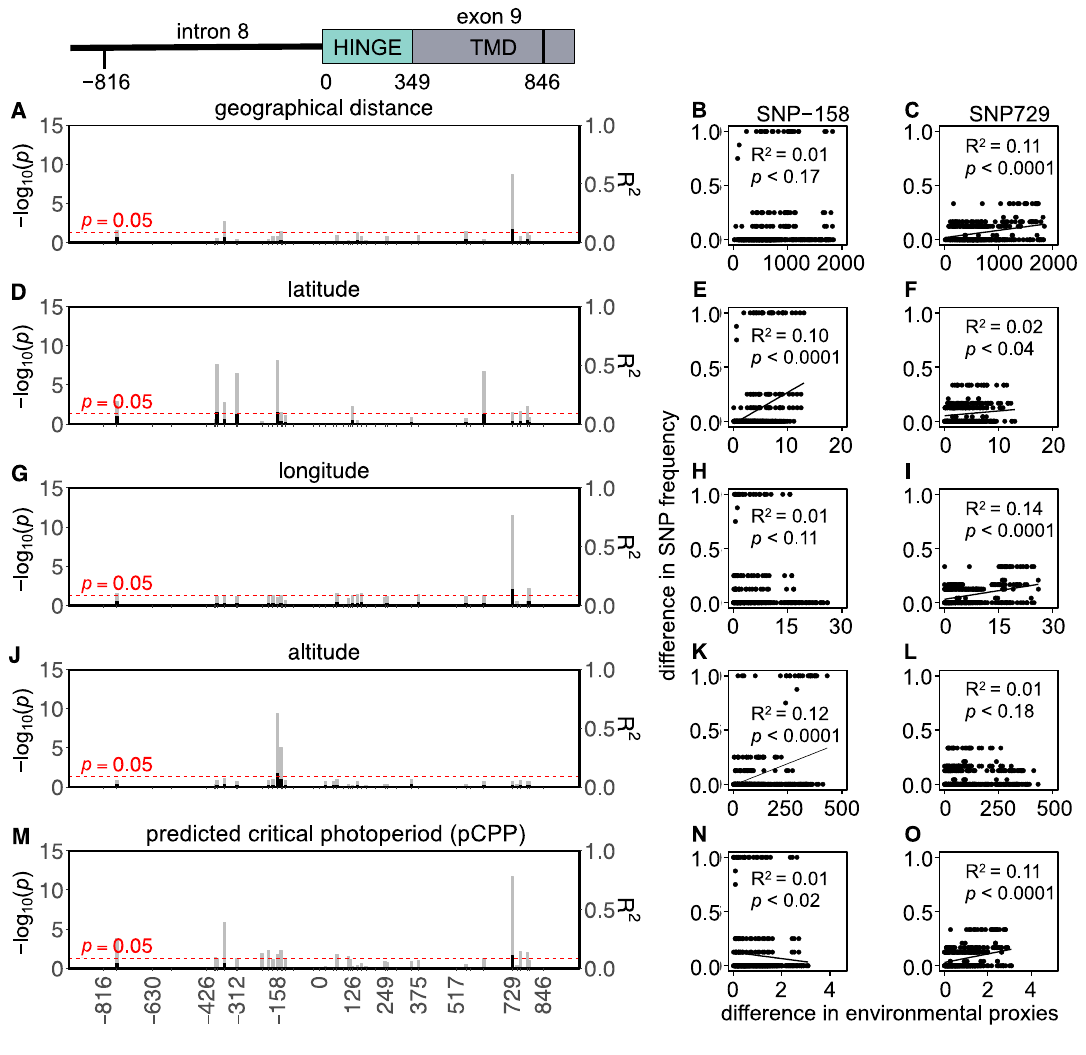
Figure 5. Tshr mutations in Eastern European common vole populations. Manhattan-type plots ( − log 10 ( p )) for the sequenced Tshr region for ( A ) geographical distance, ( D ) latitude, ( G ) longitude, ( J ) altitude, and ( M ) predicted critical photoperiod (pCPP). Gray bars indicate Benjamini–Hochberg adjusted p -values, and black bars indicate R 2 -values. SNPs that meet the threshold for significant correlations ( p < 0.05) cross the red dashed line. Pairwise differences in SNP frequency for two representative mutations (SNP-158 and SNP729) related to ( B , C ) pairwise geographical distance, ( E , F ) pairwise latitudinal difference, ( H , I ) pairwise longitudinal difference, ( K , L ) pairwise altitudinal difference, and ( N , O ) pairwise difference in pCPP. Significant correlations are indicated by linear regression lines. All statistic results of linear models for SNP frequency related to environmental proxies are found in Table